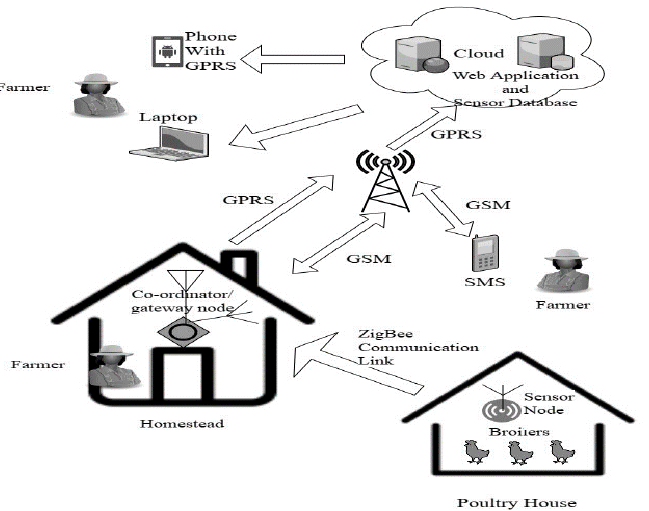
Fig. 2. Poultry Environment Monitoring IoT